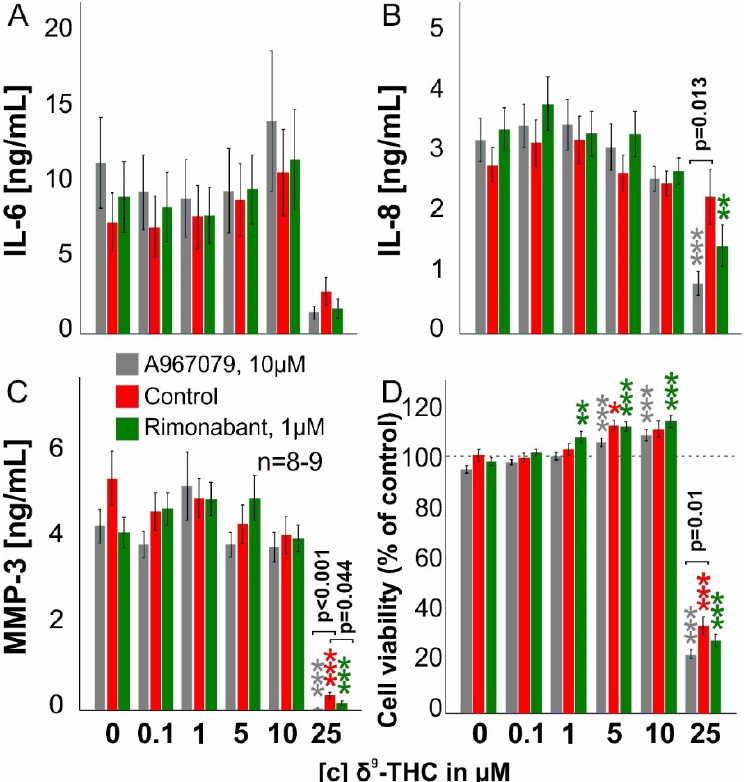
Figure 4. IL-6, IL-8, and MMP-3 production and live cell number after 72 h incubation with TNF and an additional 24 h of THC. RASF were incubated for 72 h with TNF (10 ng/mL). After wash-off, RASF were challenged with antagonists for 30 min, followed by THC (0.1–25 µM) addition for 24 h. ANOVA was used for all comparisons vs. control w/o THC. ( A – C ) IL-6, IL-8, and MMP-3 production after 24 h challenge with THC. ( D ) RASF cell number after 24 h challenge with THC. Significant differences between THC in different concentrations are depicted as * p < 0.05, ** p < 0.01, *** p < 0.001. ANOVA with Bonferroni post hoc test was used for all comparisons. Differences between THC with or without rimonabant or A9607079 are shown in the graph.